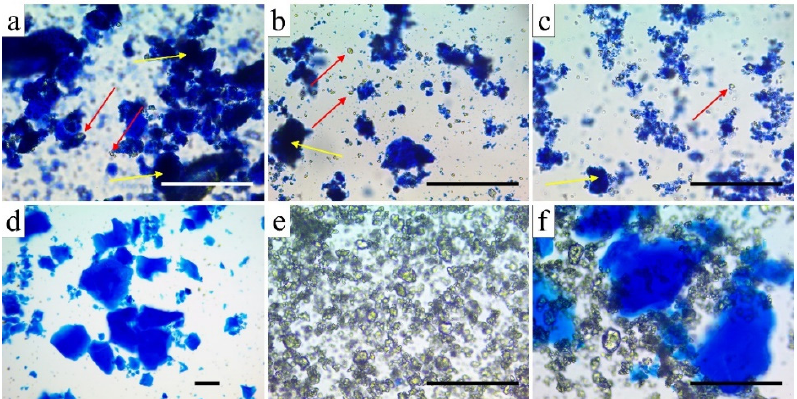
Figure 2. Optical microscopy images of ground aerogel composites, pristine silica aerogel, and β -TCP after methylene blue selective staining of the silica matrix. Red arrows indicate the largest ground and unstained β -TCP particles; yellow arrows show the largest intact composite regions. Scale bars: